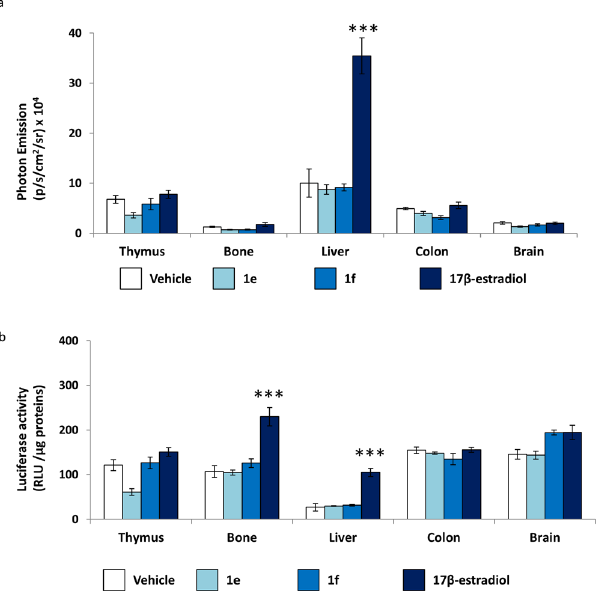
Figure 6. Analysis of the systemic effect of 1e and 1f compounds to female ERE- Luc ovx mice. ( a ) Ex vivo BLI: photon emission measured in each organ as indicated. ( b ) Enzymatic Luciferse assay: luciferase enzymatic assay performed in indicated tissue. Bars represent the mean + / − SEM of photon emission measured in 4 animals/group. ** p < 0.01 vs vehicle *** p < 0.001 vs vehicle ANOVA followed by Bonferroni’s test for multiple